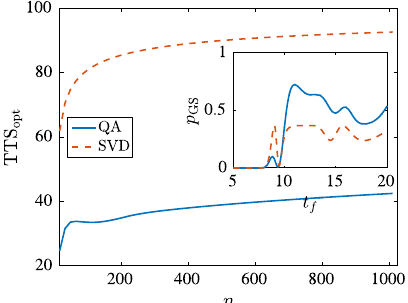
FIG. 10. The optimal TTS for the potential given in Eq. (27). QA outperforms SVD over the range of problem sizes we were able to check. The reason can be seen in the inset, which displays the ground-state probability for SVD and QA for different annealing times t , with n ¼ 512 . The optimal annealing time f for SVD occurs at the first peak in its ground-state probability ≈ 8 . 98 ), whereas the optimal annealing time for QA occurs at ( t f the much larger second peak in its ground-state probability ≈ 10 . 91 ( t f